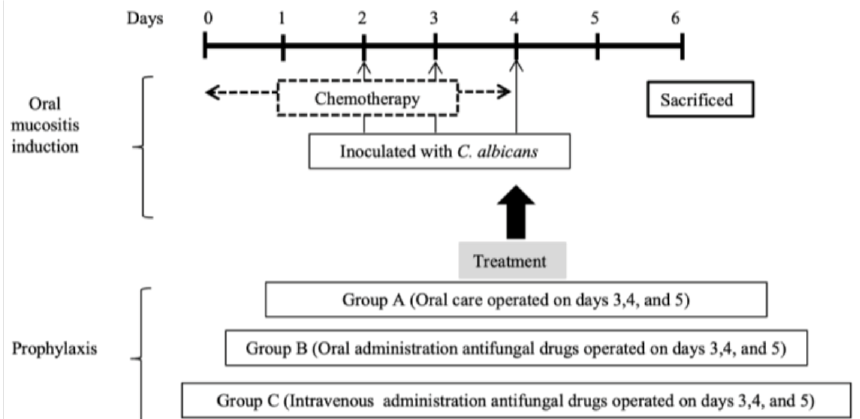
Figure 1. Experimental